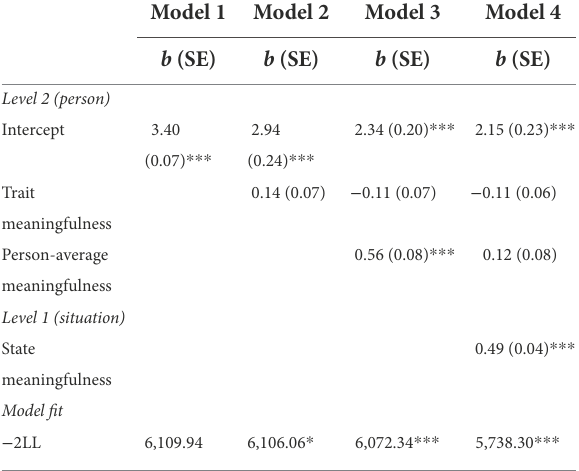
TABLE 7 Two-level linear regression results; outcome variable: state